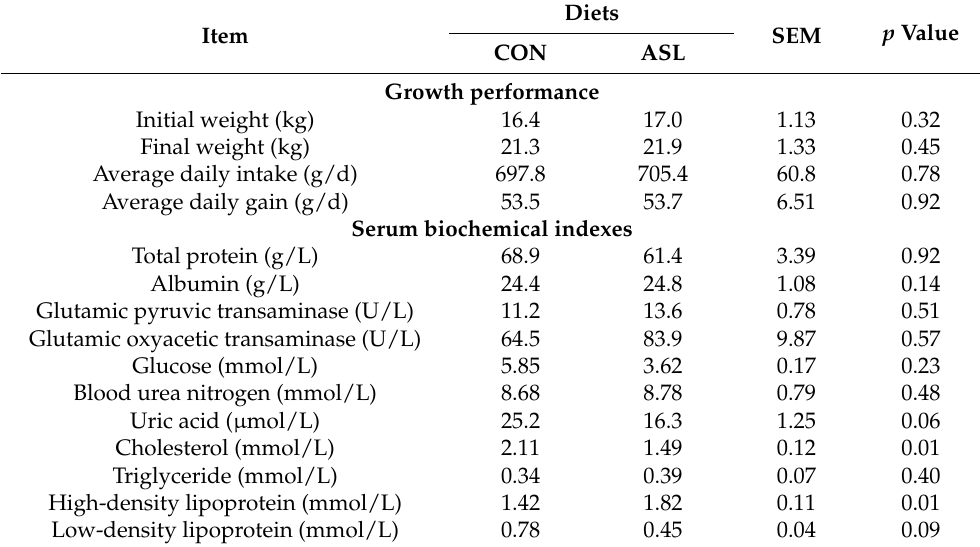
Table 3. Effects of feeding A. sinensis leaves on the growth performance and serum biochemical indexes of